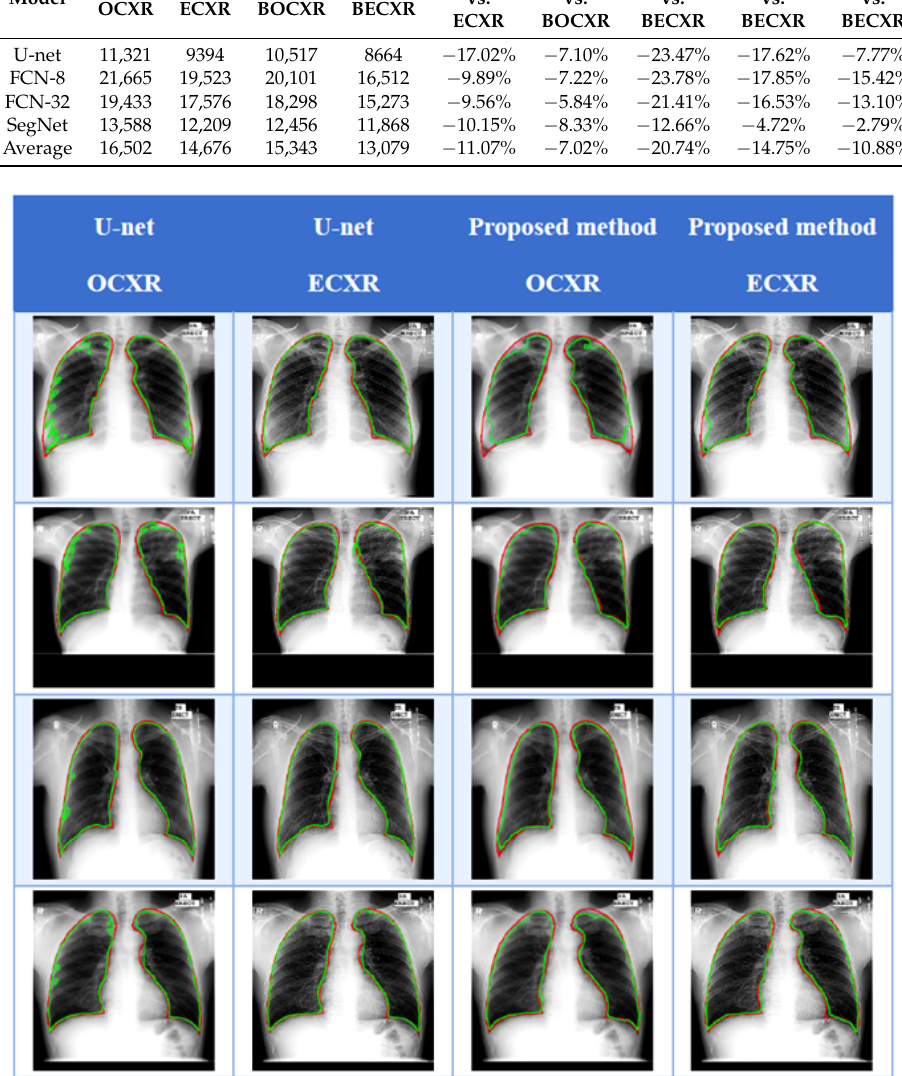
Figure 4. An example of segmentation results. The red and green contours represent the expert annotation and the estimated segmentation by the U-net model [12], respectively. Note that contrast of the figure is enhanced for